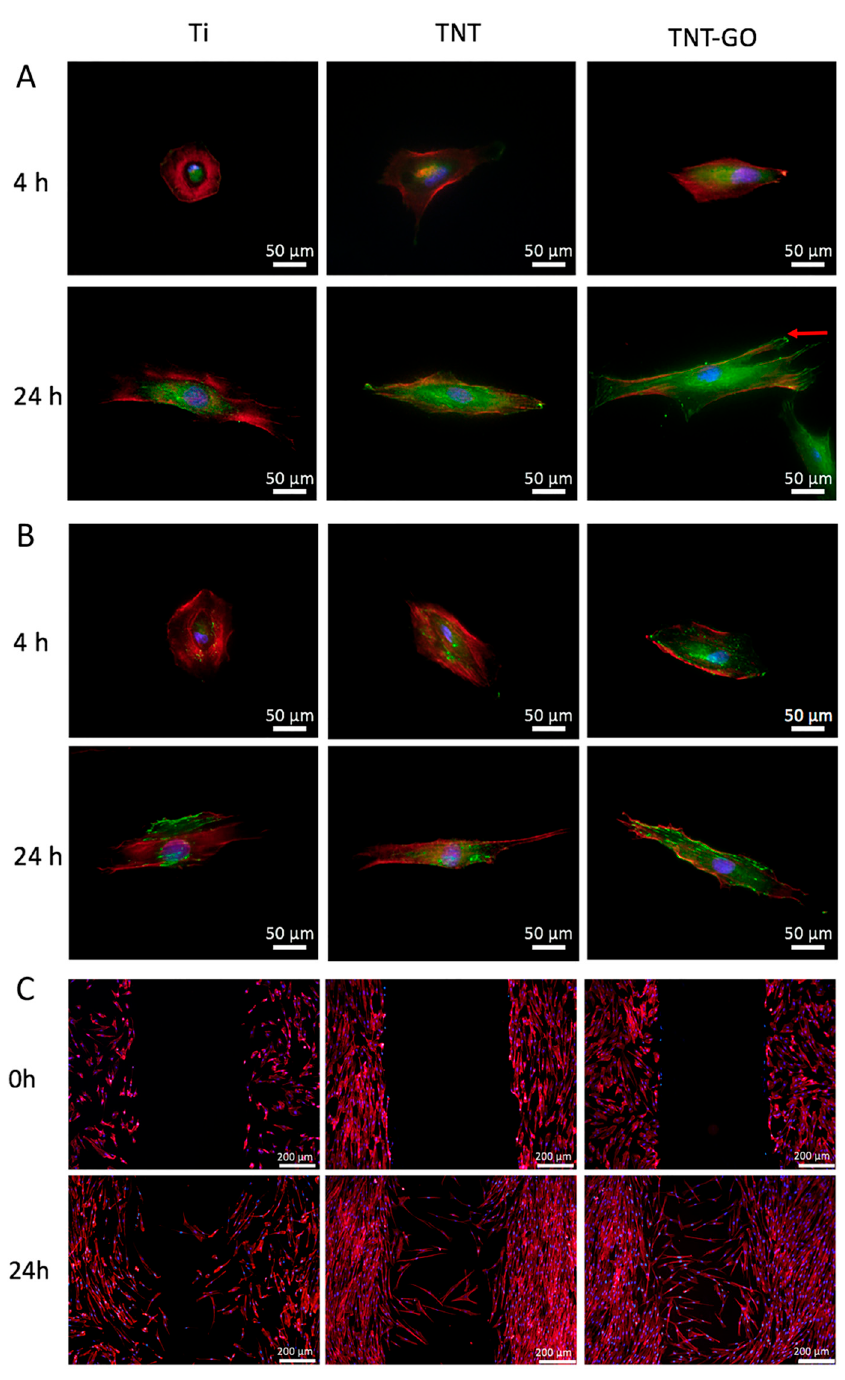
Figure 5. Immunofluorescence staining of HGFs on the different surfaces at 4 h and 24 h. F-actin was labeled red, and nuclei were labeled blue. ( A ) Vinculin (green); ( B ) integrin β 1 (green). ( C ) Wound-healing assays at 0 and 24 h. Red arrow indicates punctate mature focal adhesion sites expressed at the edge of the pseudopodia.